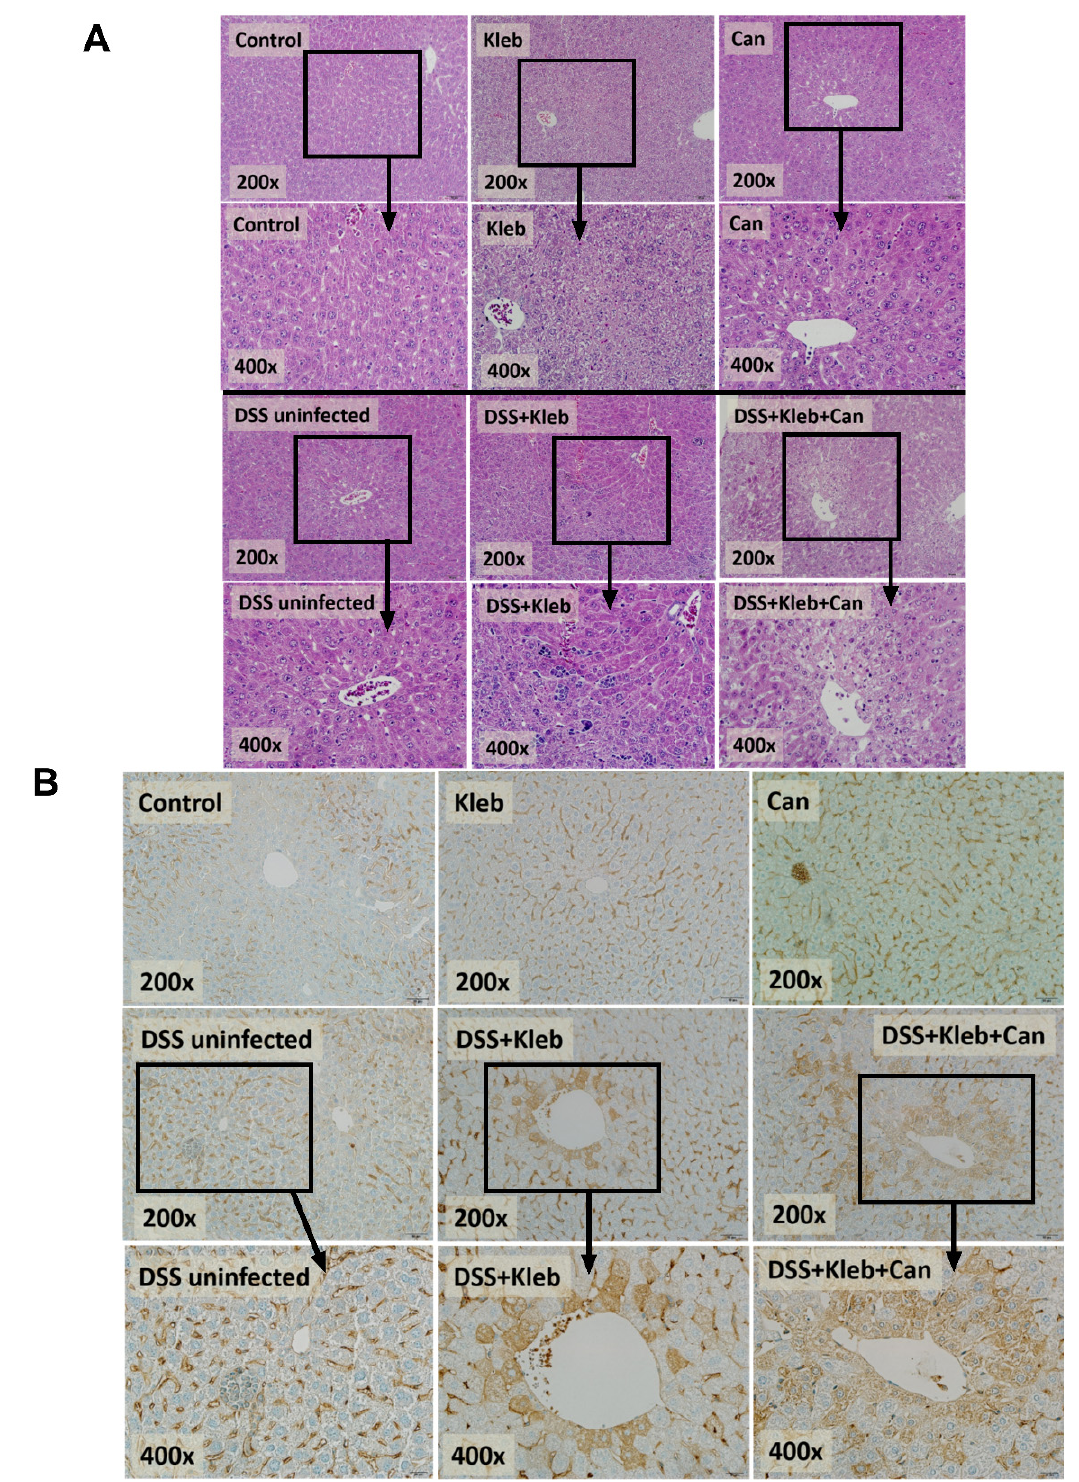
Figure 3. The characteristics of mice after daily gavage with phosphate buffer solution (control), K. pneumoniae (Kleb), or C. albicans (Can) with or without dextran sulfate solution (DSS) as indicated by representative pictures of liver histology using Hematoxylin & Eosin (H&E) color ( A ) and liver apoptosis (activated caspase 3 immunohistochemistry) ( B ). (n = 8–10/group) Notably, the semi- quantitative analyses of these histological pictures are presented in Figure